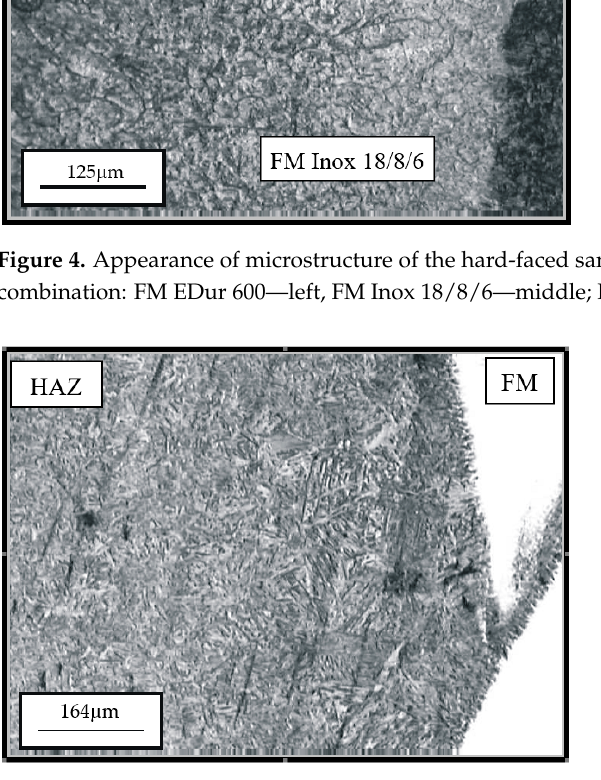
Figure 5. Appearance of microstructure of the hard-faced sample obtained by the two filler metals combination: transition from the HAZ (left) to the FM (right).